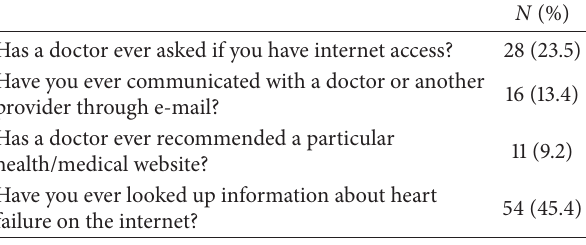
Table 2: How connected are heart failure patients?